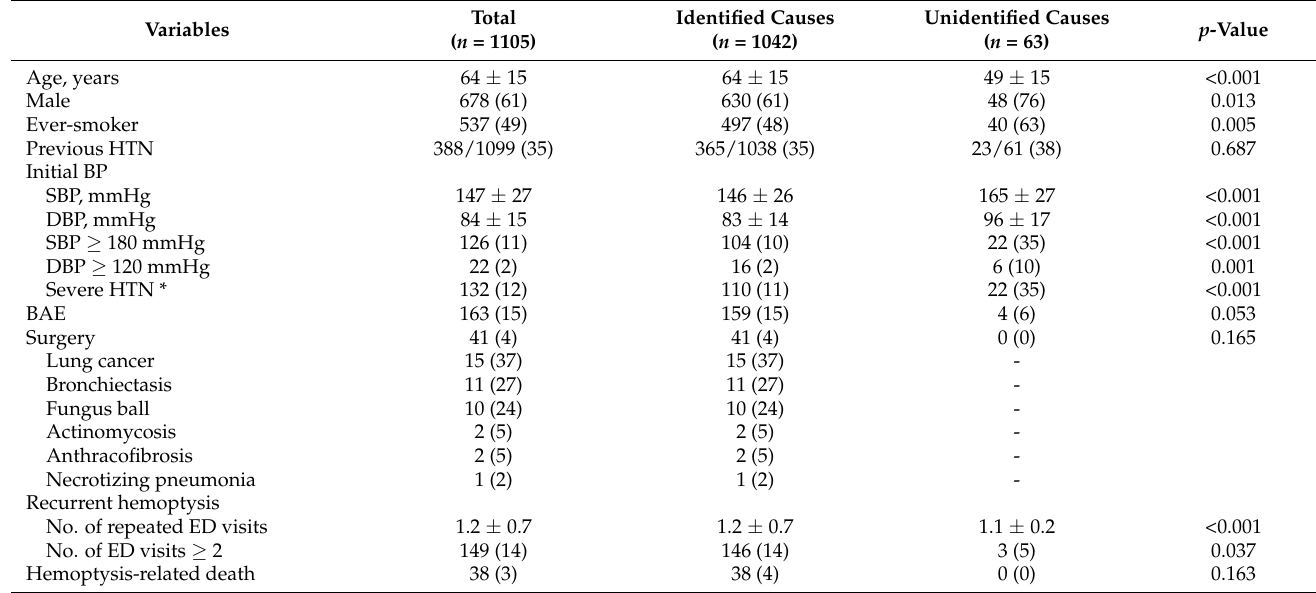
Table 2. Comparison of clinical characteristics and outcomes between patients with identified and unidentified causes of hemoptysis.